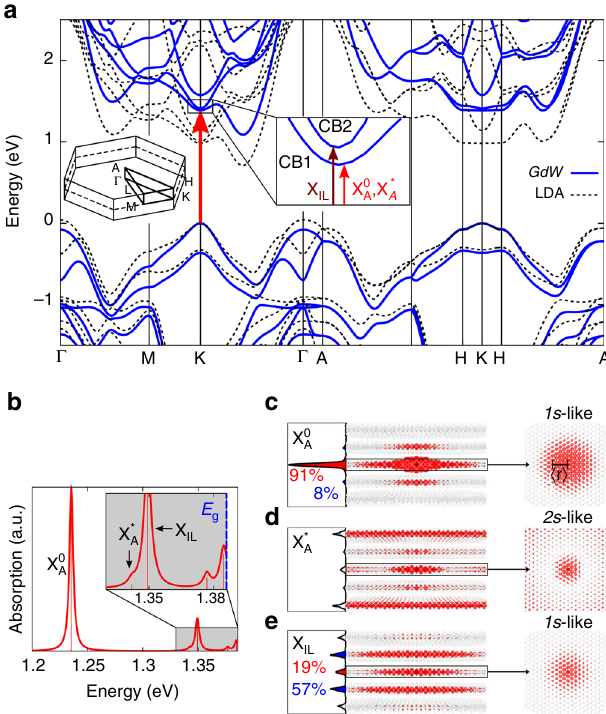
, X (cid:1) , and A A and X IL resonances. A